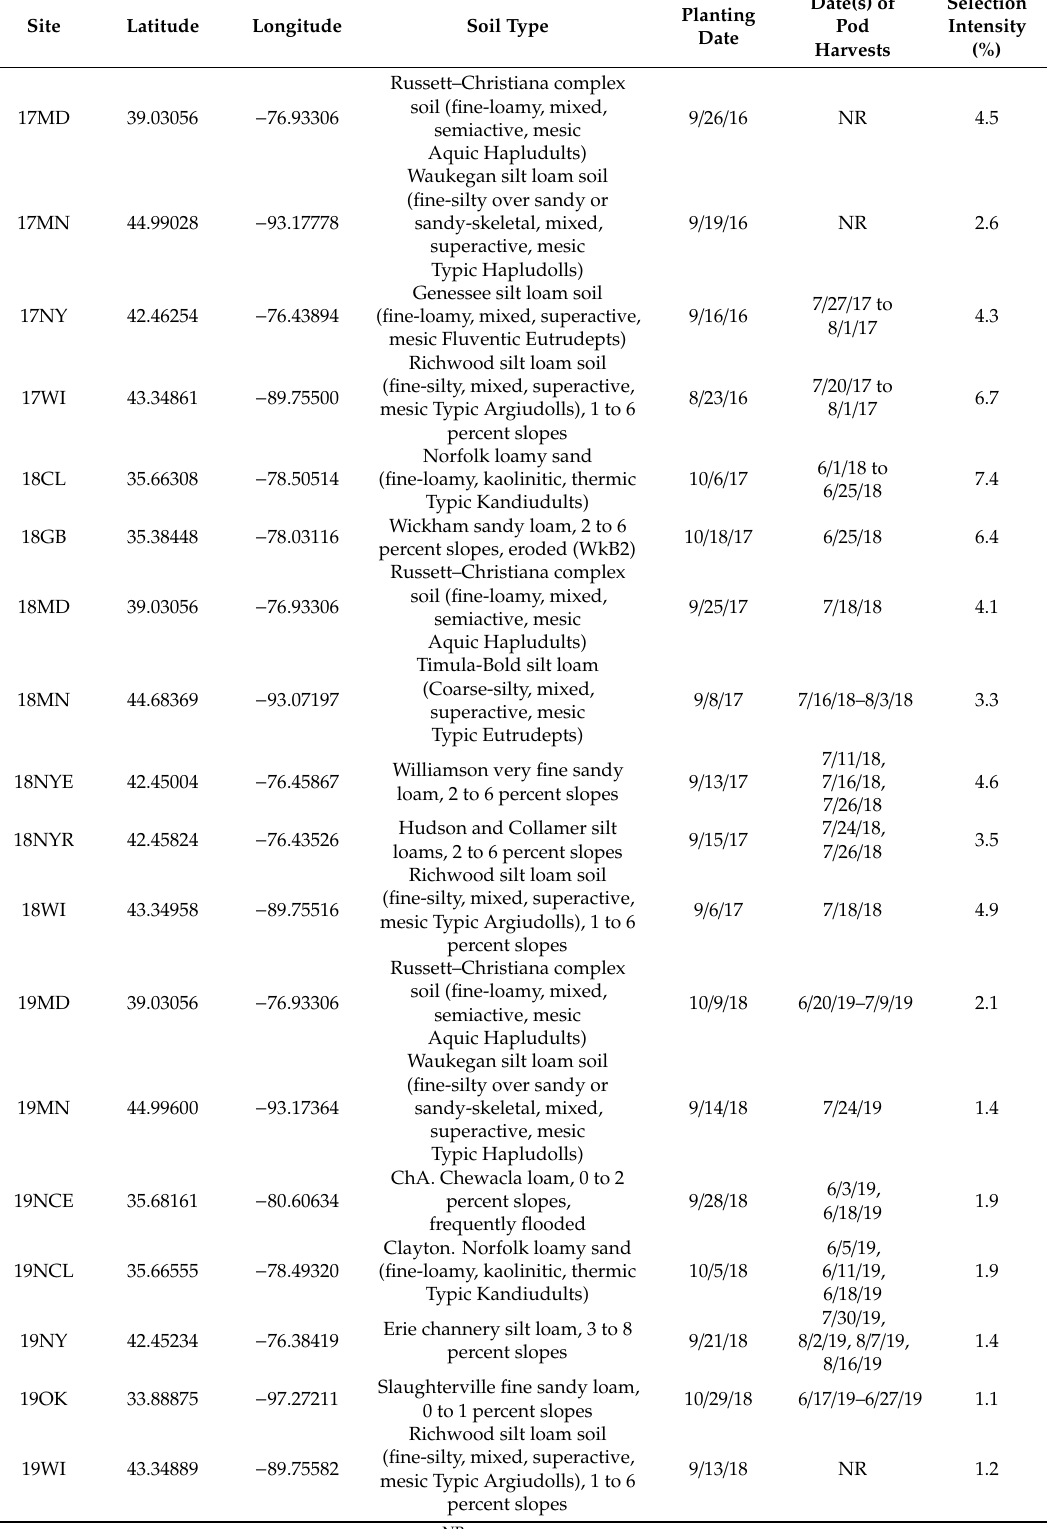
Table 1. Seed growing environments included in the analysis of physical dormancy. Latitude, soil types, planting, and pod collection dates include a broad